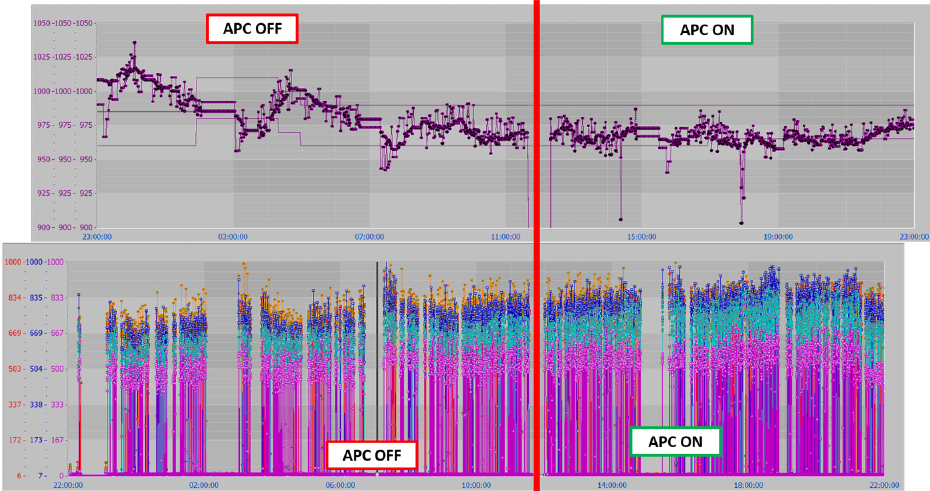
Figure 14. Control results: pre/post-APC system comparison (billets temperature at the rolling mill